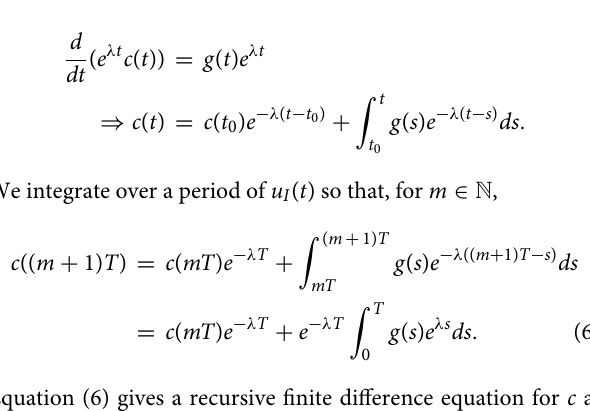
show time series plots at specific values of the delay generated using the dde23 program in MATLAB: (A) τ τ 10 . Other parameter values are n = such that τ c 1 . 5 ≈